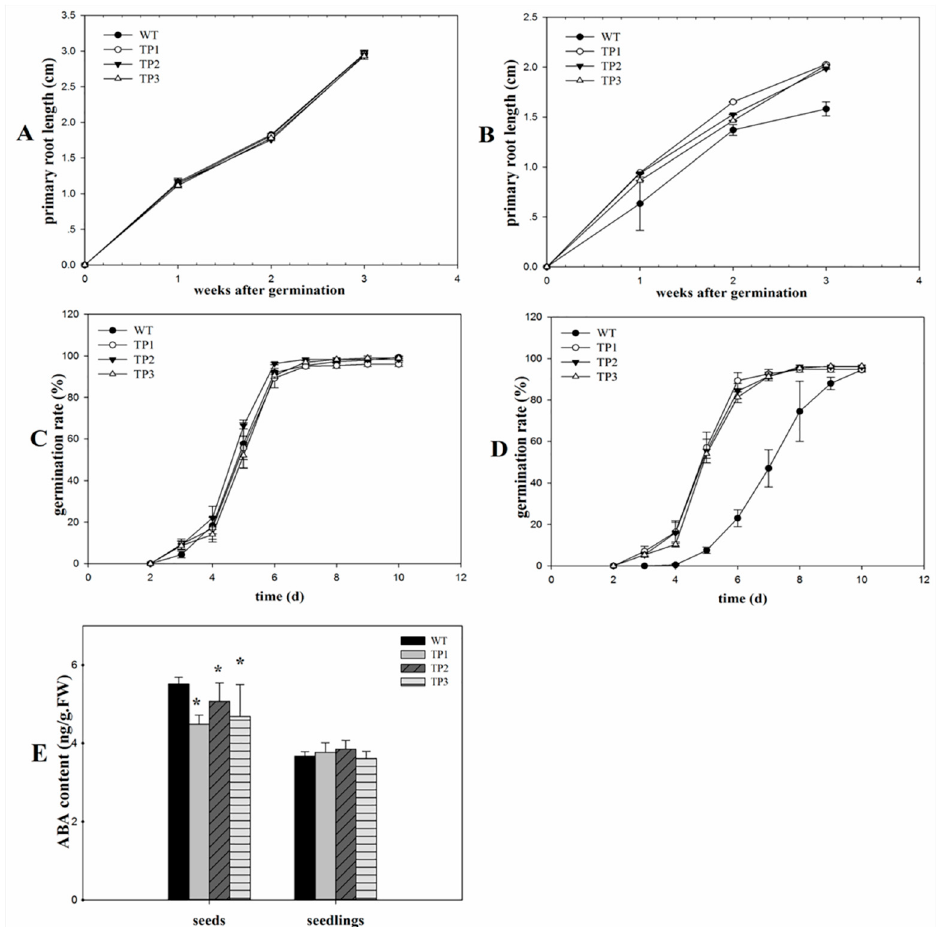
Figure 2. Phenotypic analysis of transgenic plants. ( A ) Primary root lengths of transgenic seeds and wild-type seeds under non-stress treatment conditions. ( B ) Primary root lengths of the transgenic plants and wild-type plants under non-stress treatment conditions. ( C ) Germination rates of transgenic seeds and wild-type seeds under non-stress treatment conditions. ( D ) Germination rates of the transgenic plants and wild-type plants under 150 mM NaCl treatment. ( E ) ABA content in the seeds and seedlings of the transgenic plants and wild-type plants under 150 mM NaCl treatment. Error bars indicate the standard deviation (SD). * and ** indicate that the values of the transgenic plants ( TPs) were significantly different from those of the wild-type ( WT) under the same conditions with P < 0.05 and P < 0.01.